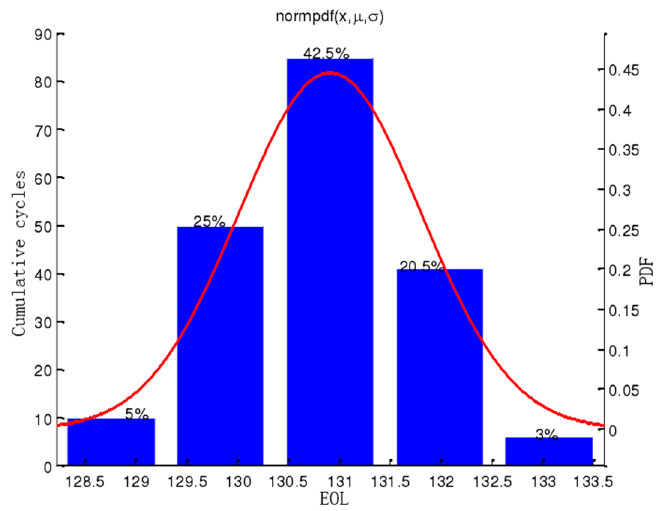
Figure 13. The PDH of LSTM prediction results at T3 = 109.